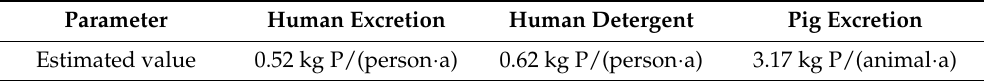
Table 1. Estimated emission parameters for humans and livestock